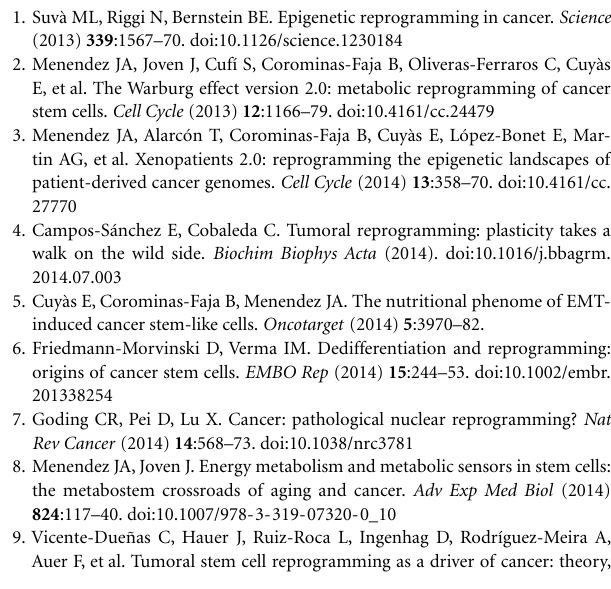
FIGURE 6 | Metabostemness: a therasnostic perspective . A qualitative and quantitative representation of the CSC-metabolic state will add a novel dynamic dimension to other well-known cancer hallmarks. Such a description of the CSC-metabolic phenome would make it possible to metabolically create non-permissive (or “hostile”) metabotypes to prevent the occurrence of cellular states with tumor- and metastasis-initiating capacities. In the clinic, the cancer metabostemness attribute will be the basis to rapidly pursue unique therapeutic approaches that target the addiction of CSCs to certain metabolic infrastructures and metabolic fluxes at the cell-intrinsic, microenvironmental, and/or systemic levels. Importantly, the opportunities and challenges for targeting the metabolic infrastructure of CSCs might be rapidly achieved because existing metabolic drugs may be easily repositioned from pre-clinical stages to clinical approaches. For instance, the drugs that would arise from the knowledge-based drug repositioning strategies selected to metabolically suppress the functionality of CSCs could silently operate as “cancer tissue sweepers” of cells capable of initiating and propagating tumors while sparing their normal counterparts. Moreover, differentiating between the specific characteristics of normal tissue SCs and CSCs may be an essential requisite for assessing the best treatment targets for CSCs while